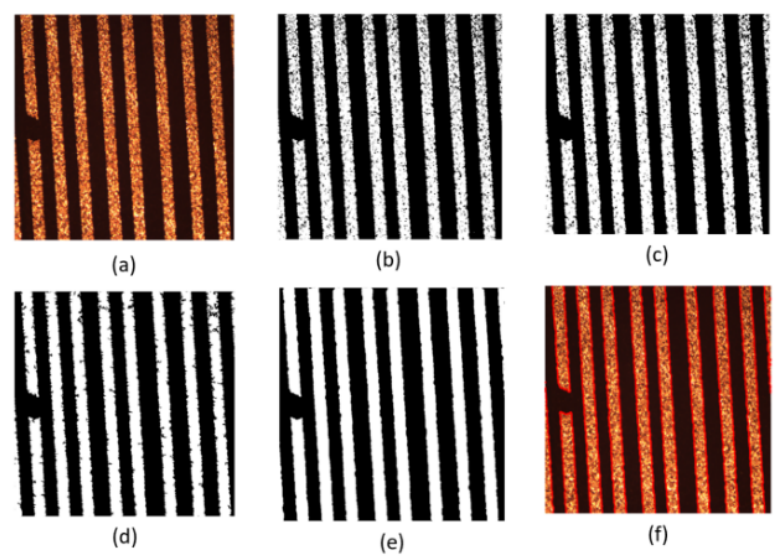
Figure 14. Display diagram of the algorithm for feature extraction of open defects. ( a ) is the original image; ( b ) is the image classified by the K-means algorithm; ( c ) is the image after median filtering; ( d ) is the image after the morphological filling hole algorithm; ( e ) is the image after the closing operation and ( f ) is the image obtained after the feature extraction of the model in this paper.